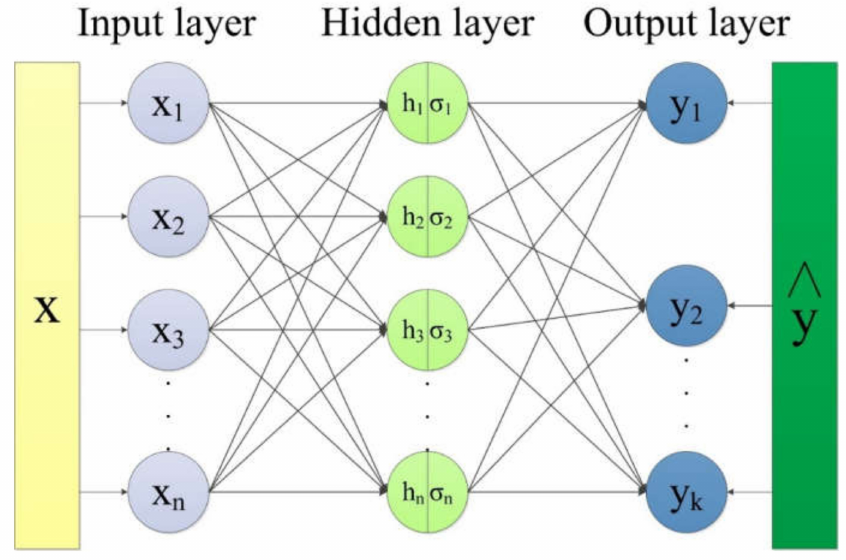
Figure 1. Schematic diagram of BP neural